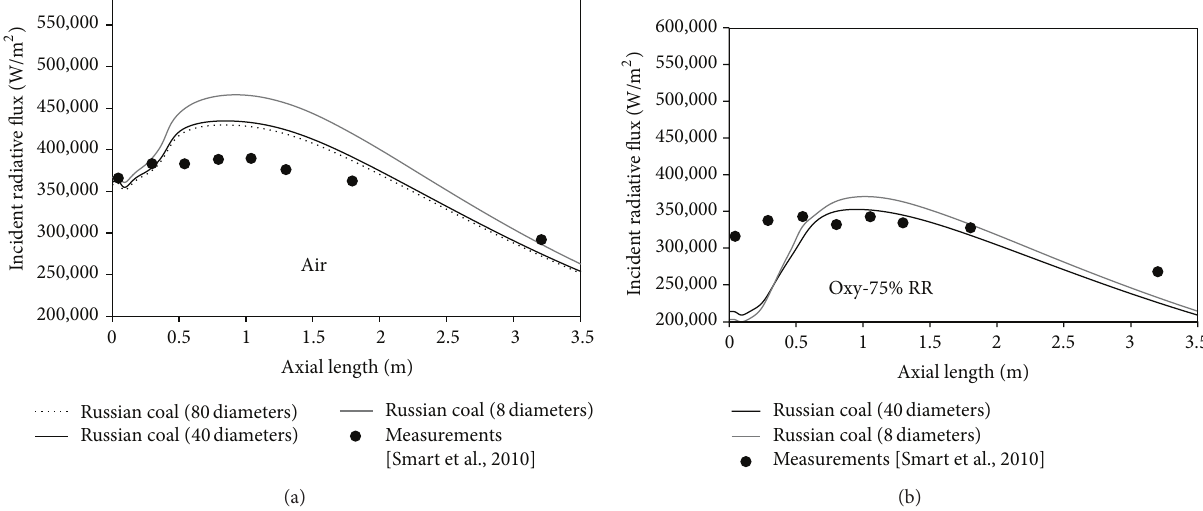
Figure 15: Sensitivities of the incident radiative fluxes to the number of diameter intervals (or resolution in the R-R distribution) during combustion of Russian